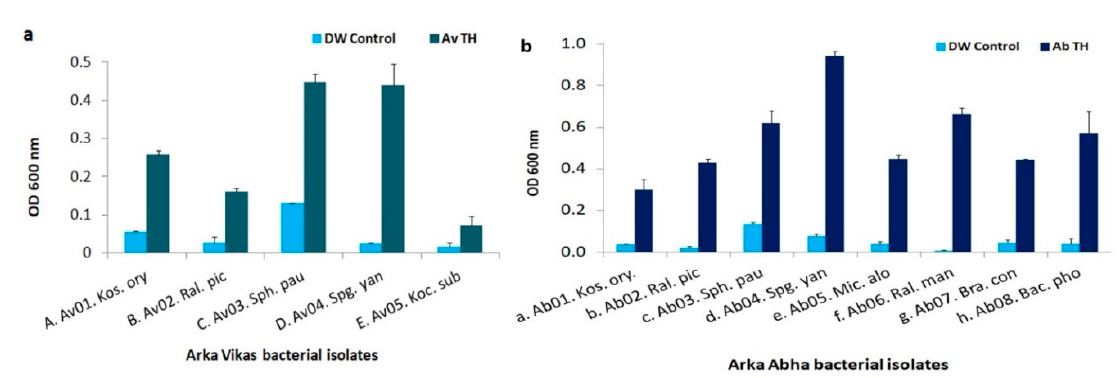
Figure 3. Host tissue extract (HTE)-based host reliance assay on the bacterial endophytes from tomato “Arka Vikas” and “Arka Abha” (as per Table 3) employing MS liquid basal medium. ( a ), “Arka Vikas” seedling isolates in MS liquid medium supplied with 10% (v/v) “Arka Vikas” HTE and ( b ), “Arka